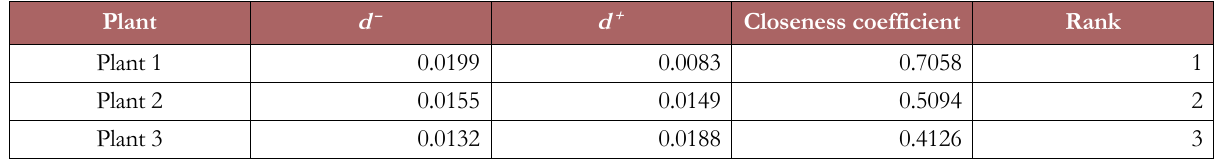
Table 12. Distance, closeness coefficient and the rank of each plant (IoT)